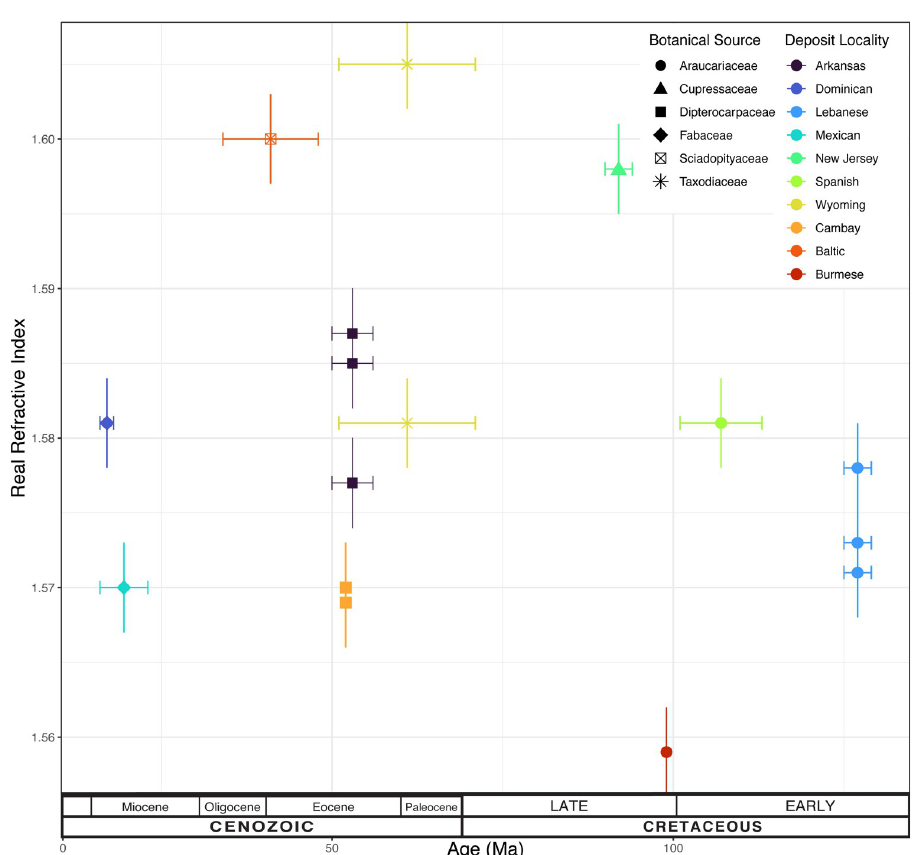
Fig 4. Real refractive index as measured by time-of-flight versus sample age. Botanical source and locality indicated by point shapes and colors, respectively. Horizontal bars denote age ranges noted in Table 1, vertical bars depict uncertainty of the refractive index measurements at ±